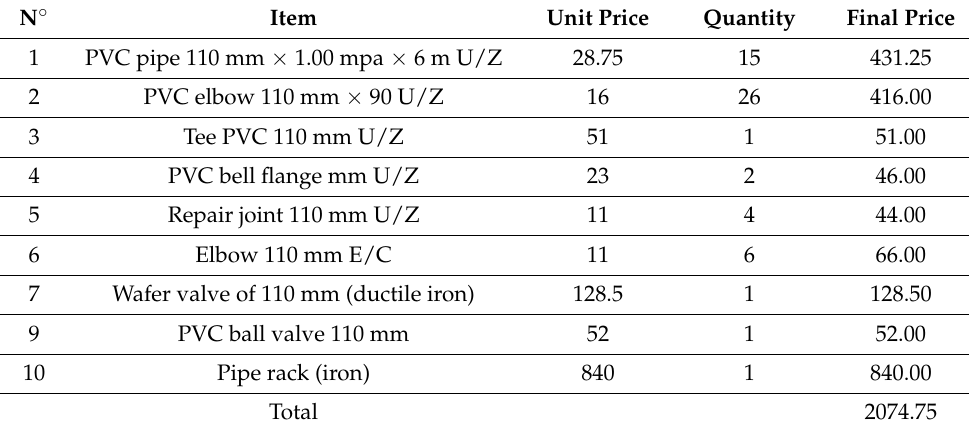
Table 15. Summary of Materials and Used